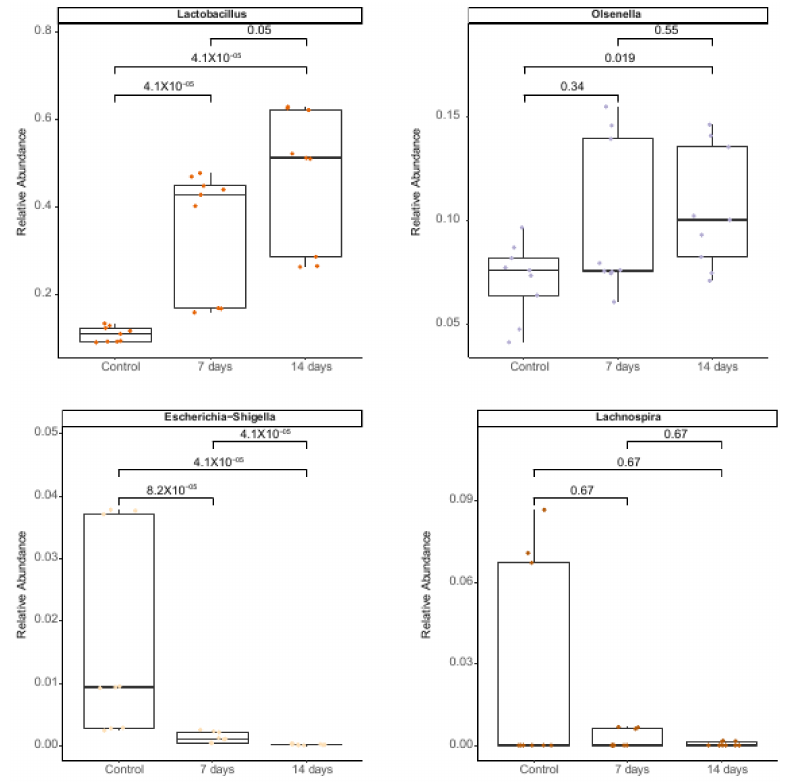
Figure 5. Relative abundance of bacterial genera in microbiota of individuals with mild anxiety using the SHIME ® model over the course of the 7 or 14 days of treatment with L. helveticus R0052 and B. longum R0175. Differences in means were analyzed using the Wilcoxon